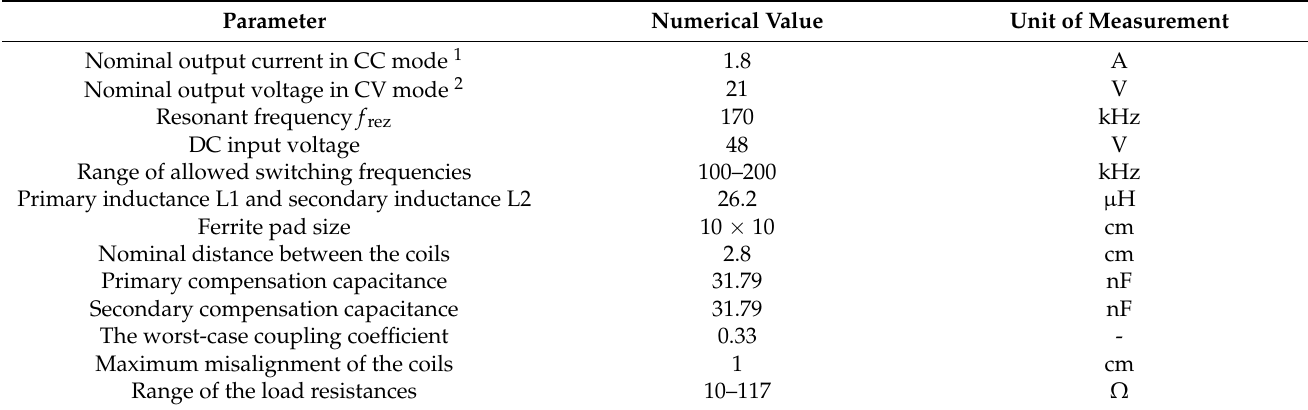
Table 1. The parameters values of the designed WPT system.